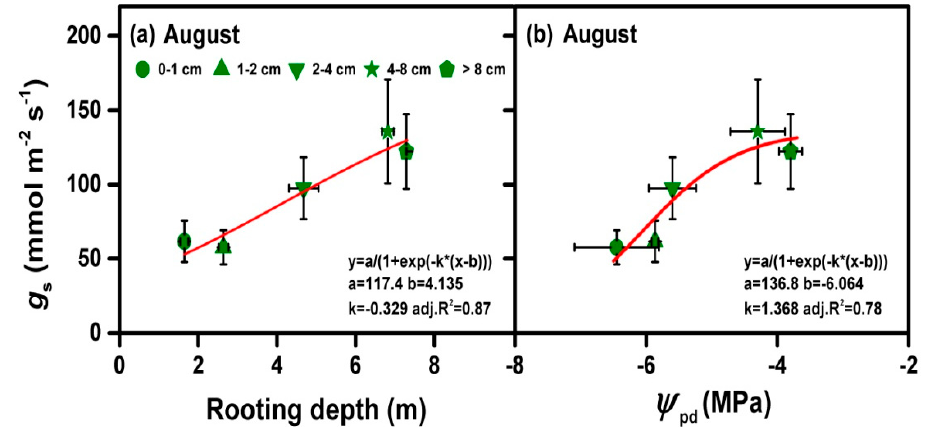
Figure 6. Stomatal conductance (g s ) in relation to rooting depth ( a ) and predawn leaf water potential ( Ψ pd , b ). Data are presented as mean ± 1 SE ( n = 5).